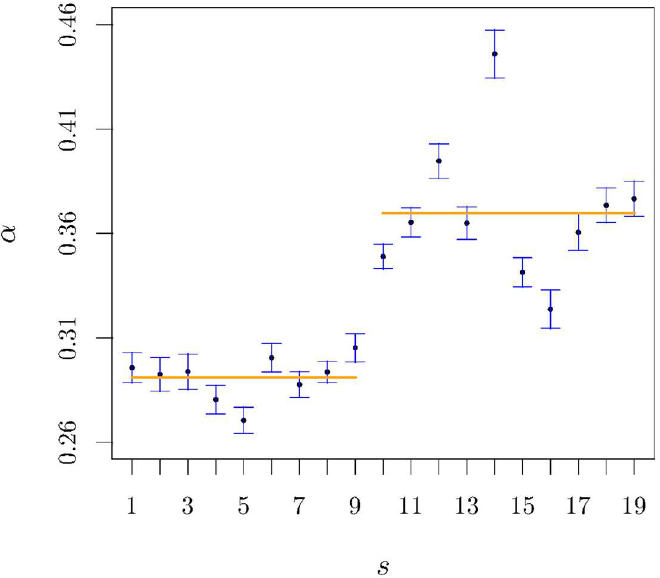
Fig 2. The symbols represent the exponent α in Eq (9) v semester s . The solid horizontallines indicate the value of the exponent averaged over the semesters before and after semester 10. The value of t in the Wech’s test of equivalenceof the means is equal to 5.56 whereas for critical value with a confidence level of 95% is t crit = 1.86. That differenceis corroborated by the Mann-Whitney-Wilcoxon test with a significance of 95% as